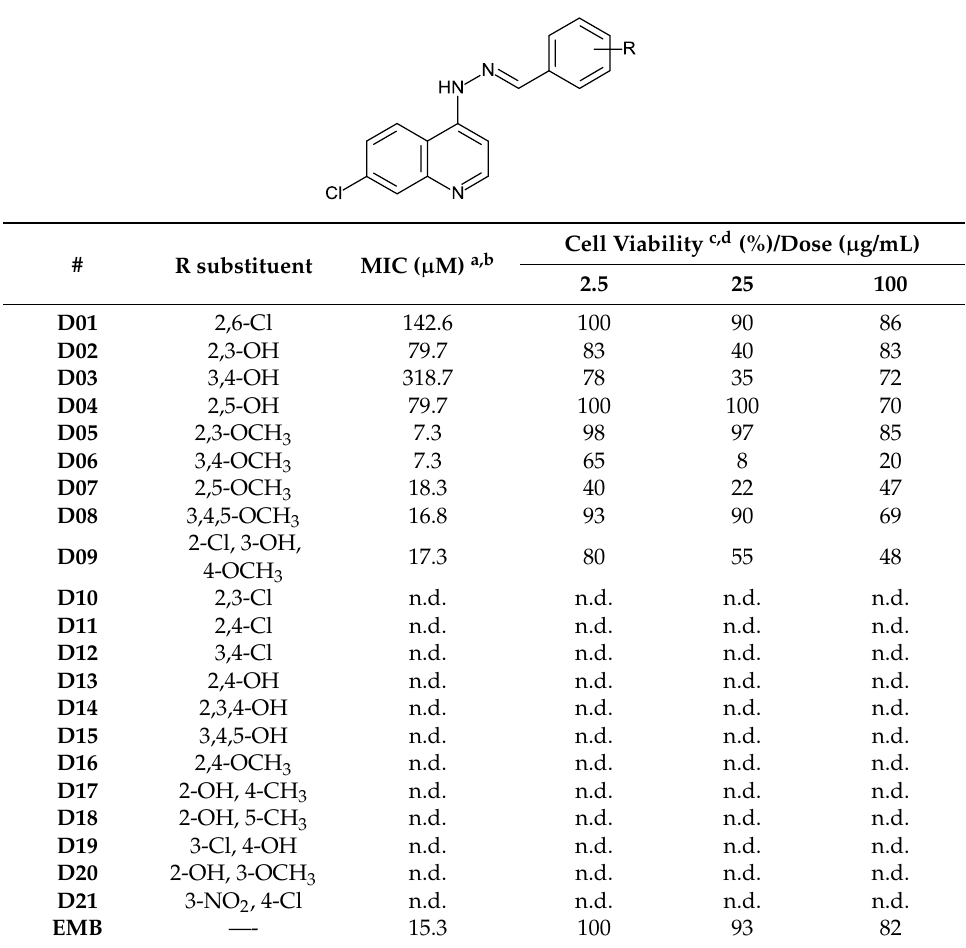
Table 1. Chemical structures (R substituent), anti-mycobacterial (minimum inhibitory concentration, MIC) and cytotoxicity (cell viability at drug doses of 2.5, 25, and 100 μg/mL) activities of series D ( D01 – D21 ) and ethambutol (EMB).